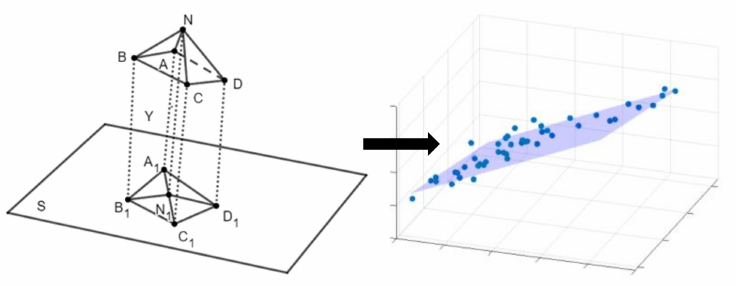
Figure 2. Schematic diagram of 2D projection and the reference planar. The 3D fault points A, B, C, D, and N are projected to the 2D reference planar S, corresponding to points A 1 , B 1 , C 1 , D 1 , and N 1 .